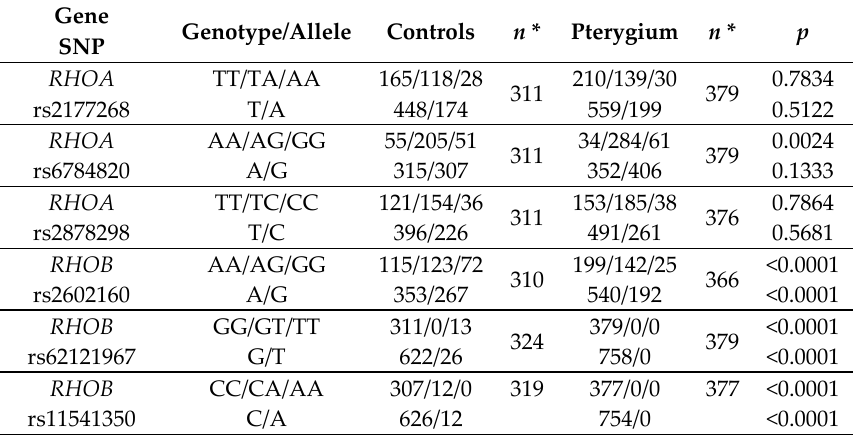
Table 1. Genotype and allele distributions of RHO gene polymorphisms in pterygium patients and control